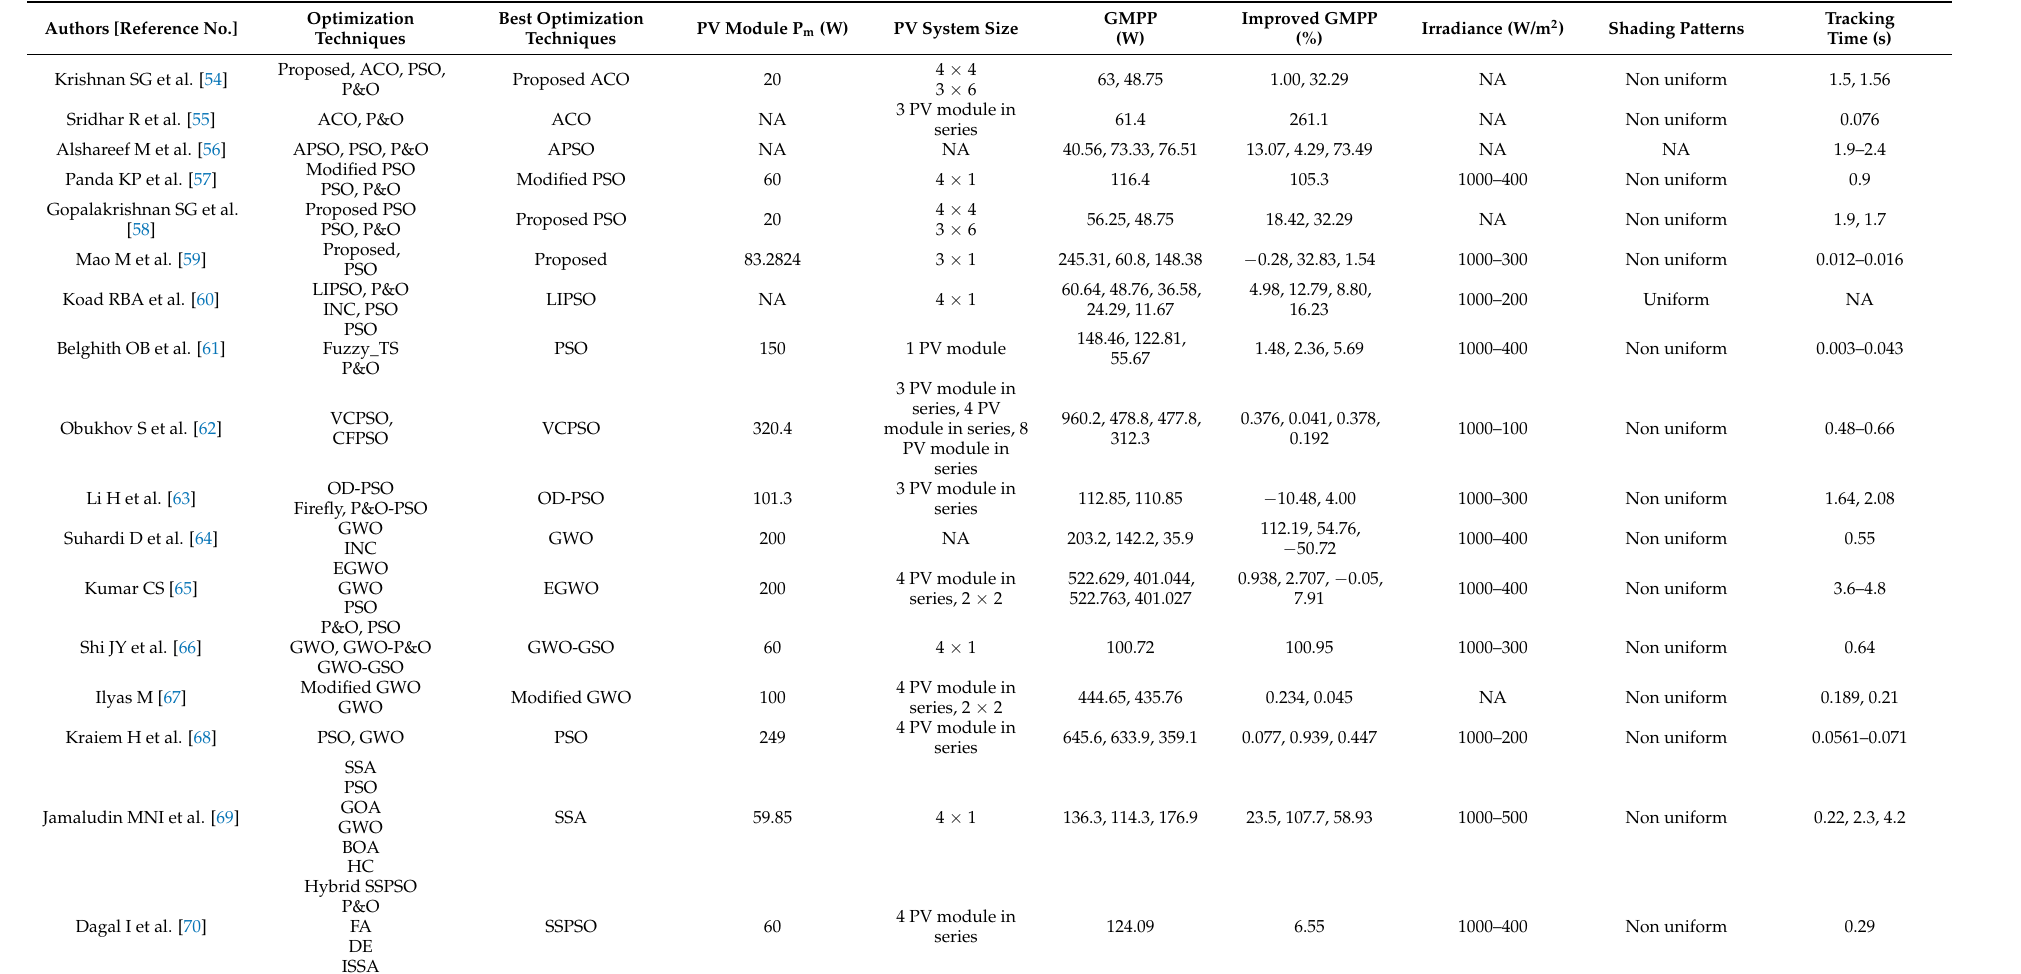
Table 3. Taxonomy on recent reported work on swarm intelligence techniques to track